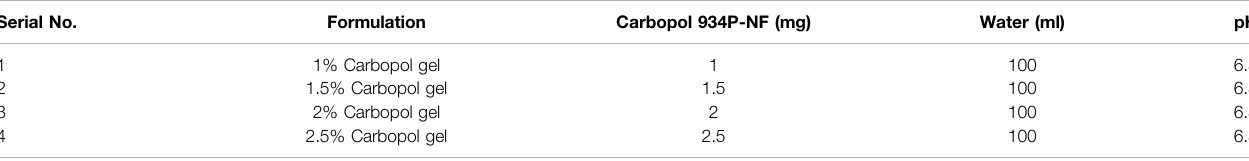
TABLE 2 | Various formulations of Carbopol 934P-NF gel base. Serial No.